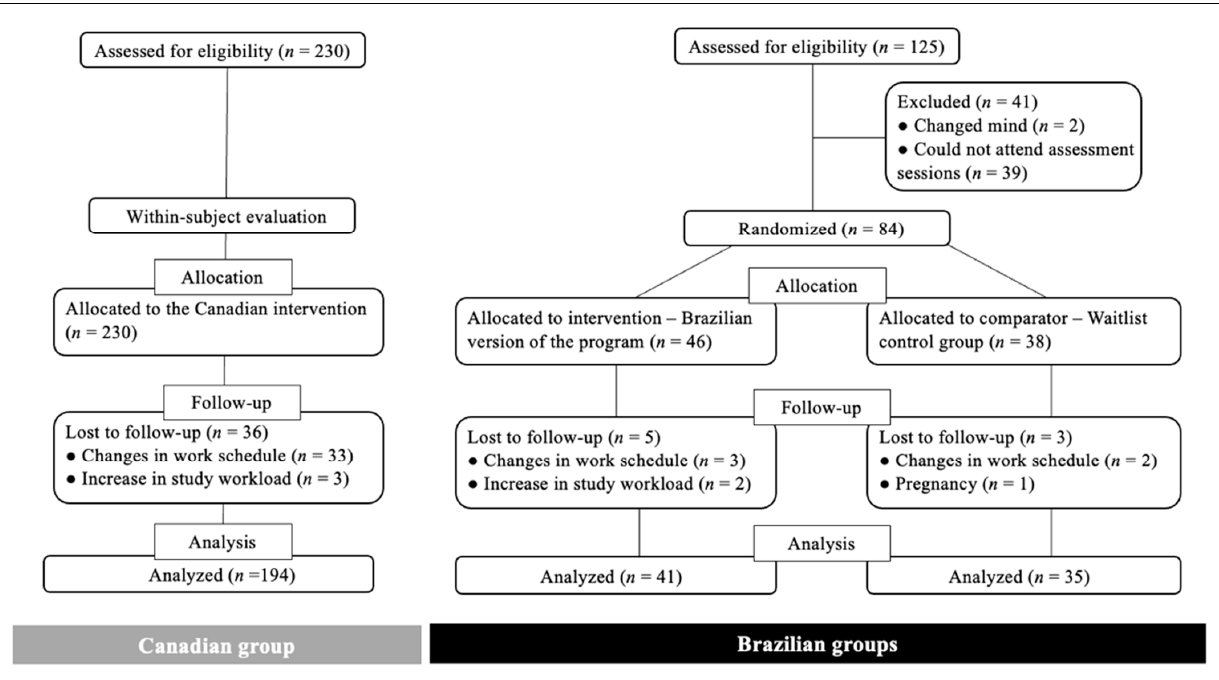
Figure 1. Flow of participants through the study.